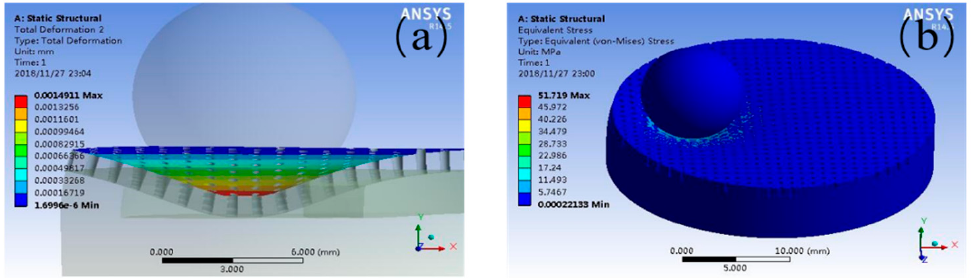
Figure 9. Steady-state coefficients of the pocket-textured surface and blank surface under different loads while the sliding frequency is kept at 0.5 Hz.